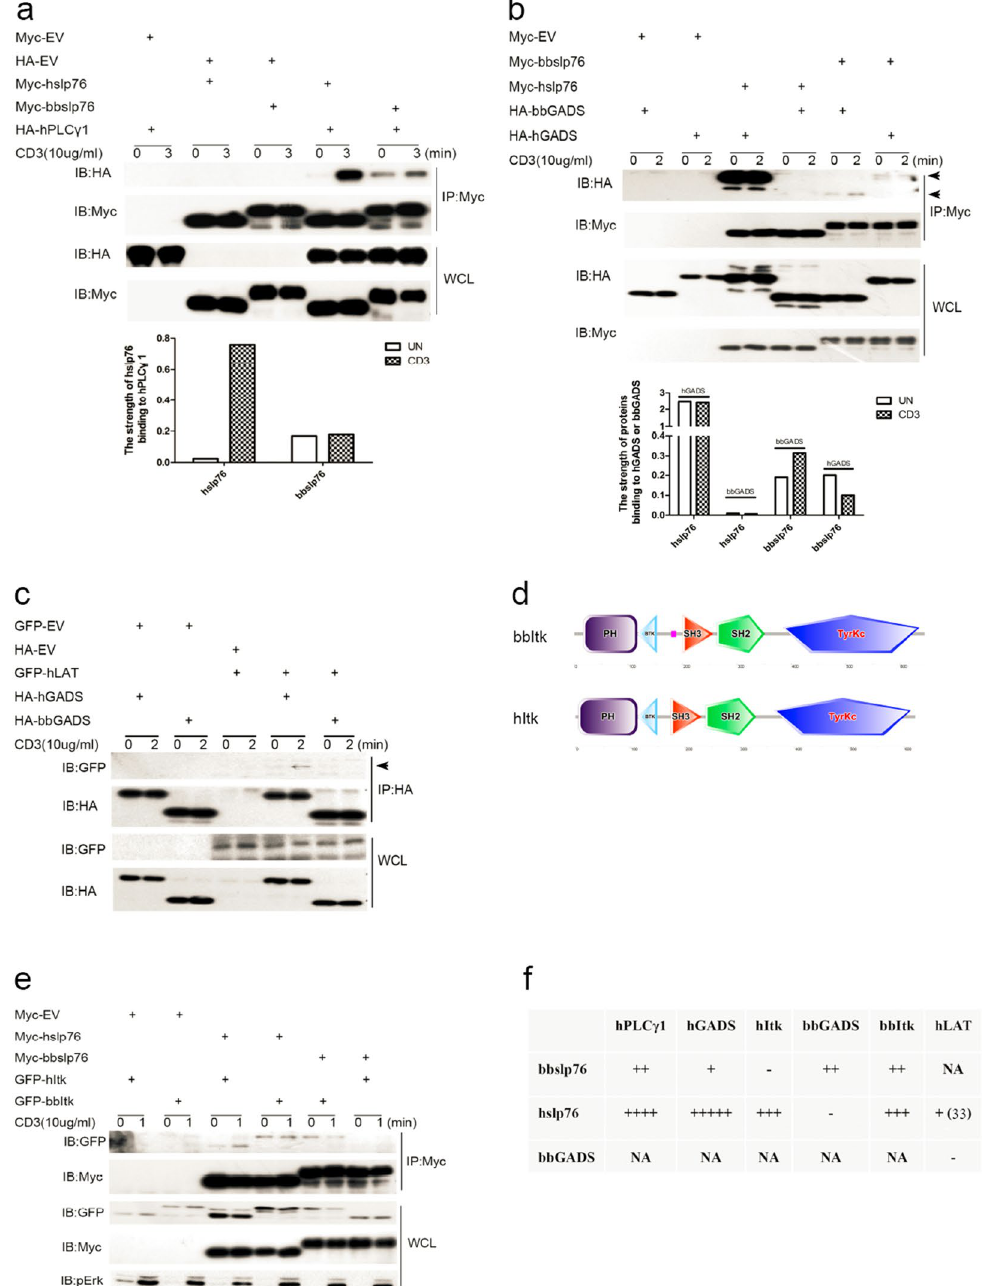
Figure 4. bbslp76 interacts with TCR proximal signal proteins. ( a ) bbslp76 interacts with hPLC γ 1 in T cells. Jurkat TAg cells were transfected with the indicated constructs. After 48 hrs, cells were stimulated with or without CD3 (10 μ g/mL, 3 min); then, lysed and lysates were split into two parts, one part of the lysates was subjected to a Myc IP (immunoprecipitation), and the other part was used for WCL (whole cell lysis, 40 μ L). Samples were studied by western blot, and probed with indicated antibodies. The binding affinity is normalized by IB HA to IP Myc. ( b ) The interaction of bbslp76 or hslp76 with bbGADS or hGADS in T cells. Cells and lysates were prepared as in ( a ). Samples were studied by western blot, and probed with indicated antibodies. The upper arrow indicates hGADS. The lower arrow indicates bbGADS. The binding affinity is normalized by IB HA to IP Myc. ( c ) bbGADS does not interact with hLAT in T cells. Cells and lysates were prepared as in ( a ). One part of the lysates was subjected to a HA IP. Samples were studied by western blot, and probed with indicated antibodies. The arrow indicates hLAT. ( d ) Protein structures of bbItk and hItk generated by SMART. ( e ) bbslp76 does not interact with hItk in T cells. Cells and Lysates were prepared as in ( a ). Samples were studied by western blot, and probed with indicated antibodies. ( f ) Summary of binding affinities between bbslp76 and TCR proximal signal proteins. NA: not available; The experiments were repeated three times with very similar results. The strength of protein-protein interaction was analyzed by software Quantity